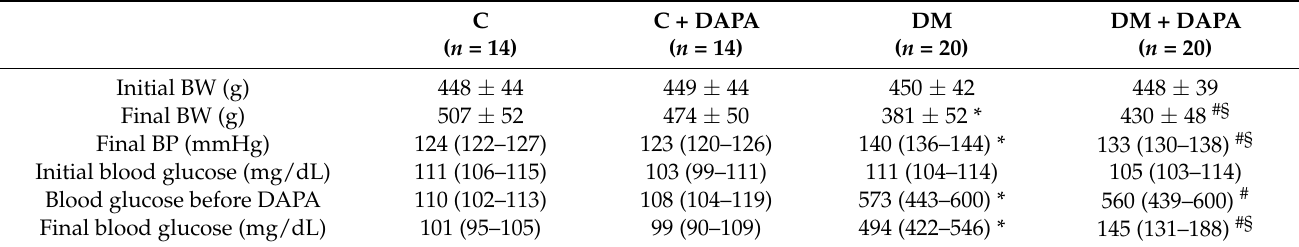
Table 1. Body weight, systolic blood pressure, and blood glucose.